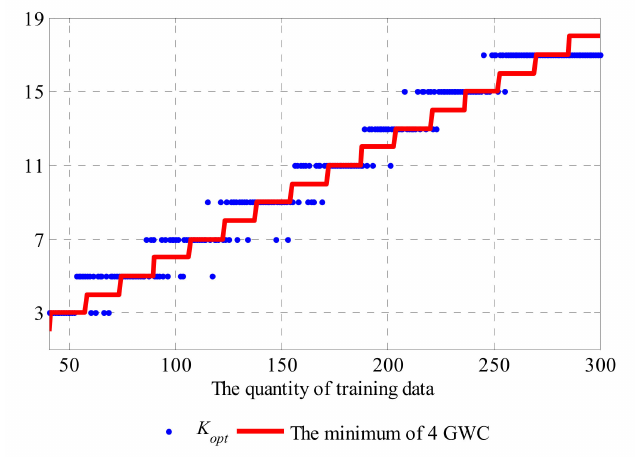
Figure 22. K opt and the minimum quantity of the four GWC training samples with different overall training sample